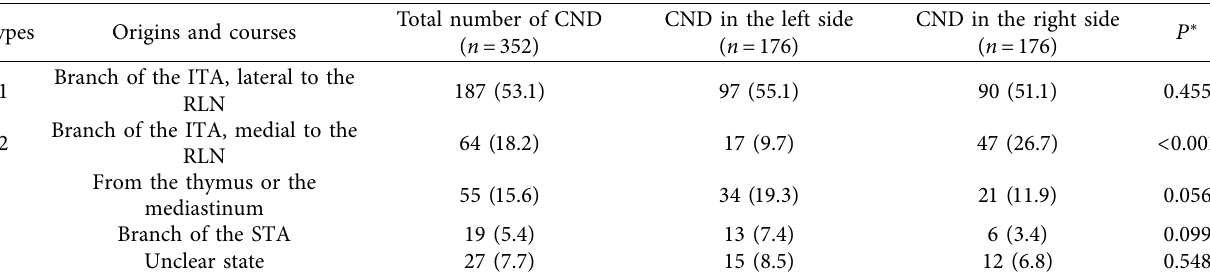
Figure 1: Diagram of the origin and course of blood supply to the inferior parathyroid gland Table 2: Origins and courses of blood supply to IPTGs.